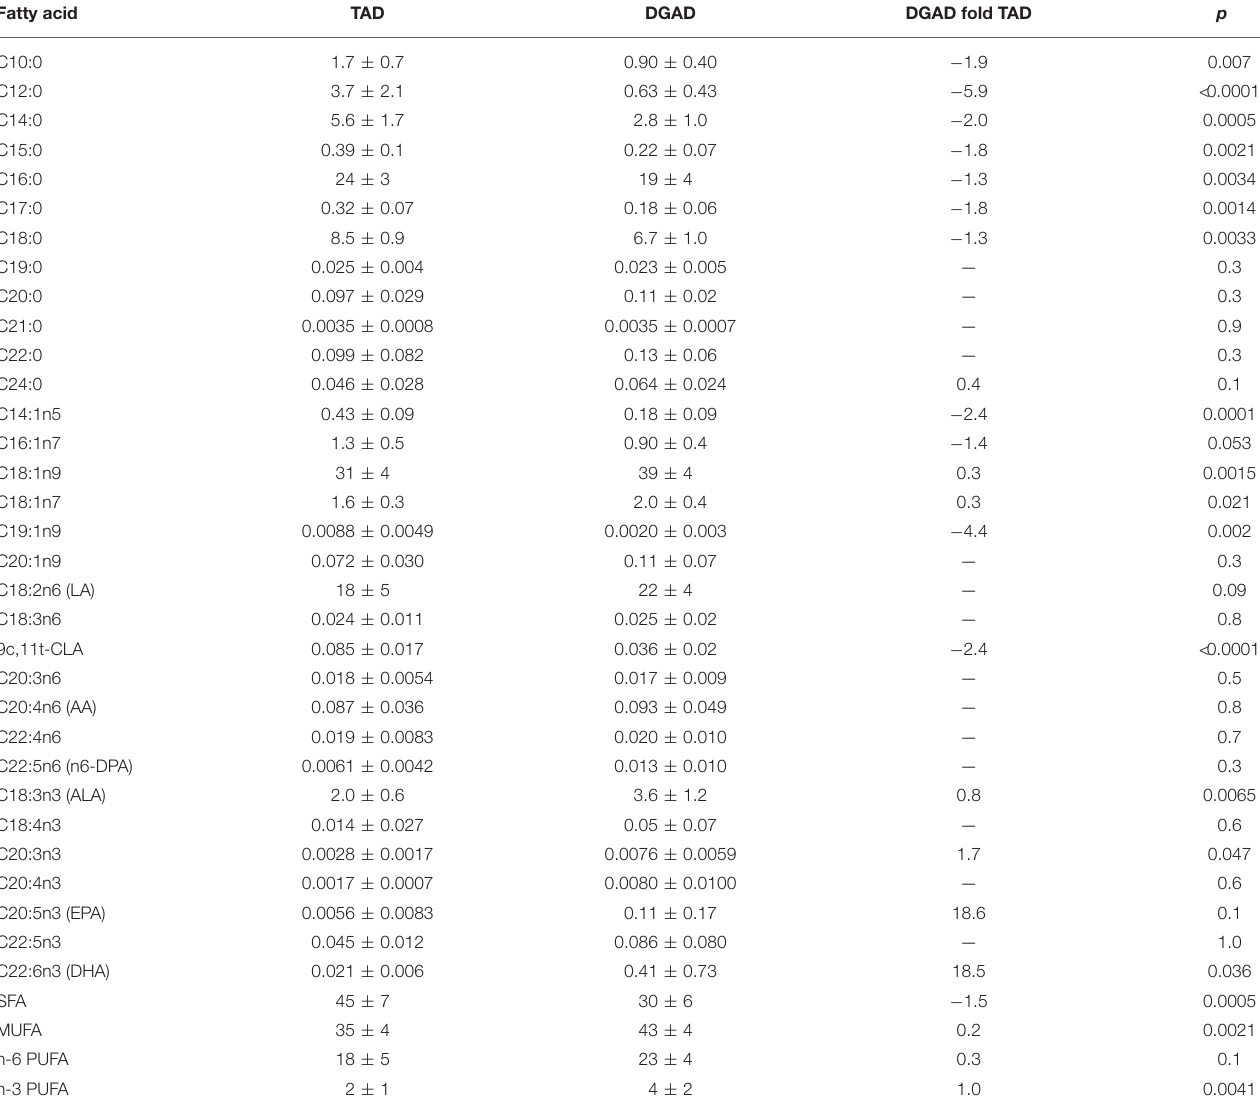
TABLE 2 | Average meal composite fatty acid composition (mol%) a